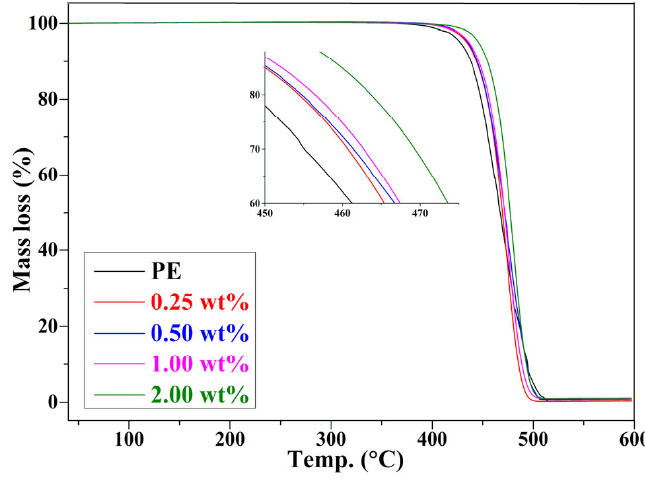
Figure 7. TG curves of PE and graphene/PE composites.